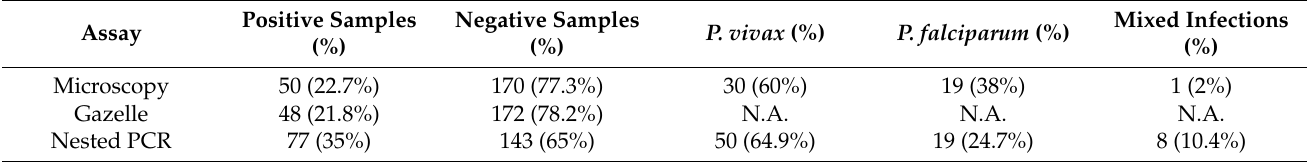
Table 2. Number of positive and negative samples for malaria according to three diagnostic tests and parasite species identification.